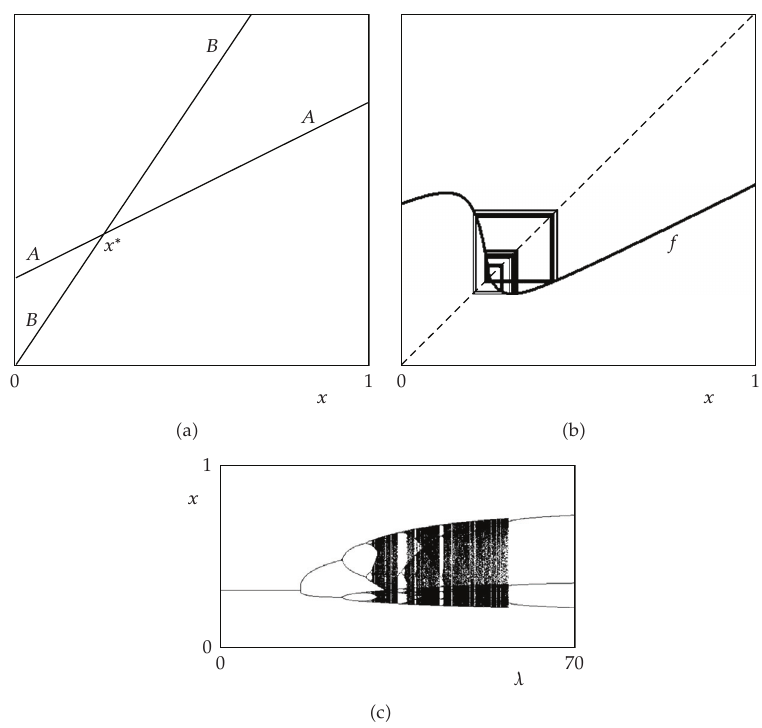
Figure 2: (cid:2) a (cid:3) Payo ff functions A (cid:2) x (cid:3) (cid:7) 1 . 5 x , B (cid:2) x (cid:3) (cid:7) 0 . 25 (cid:8) 0 . 5 x . (cid:2) b (cid:3) Function f obtained with g (cid:2) · (cid:3) (cid:7) (cid:2) 2 /π (cid:3) arctan (cid:2) · (cid:3) , the same payo ff s as in (cid:2) a (cid:3) and parameters δ is unstable and the generic trajectory converges to the attractor shown around x ∗ . (cid:2) c (cid:3) Bifurcation diagram obtained with the same values of parameters δ and payo ff functions as in (cid:2) b (cid:3) and bifurcation parameter λ ∈ (cid:2) 0 , 70 (cid:3)